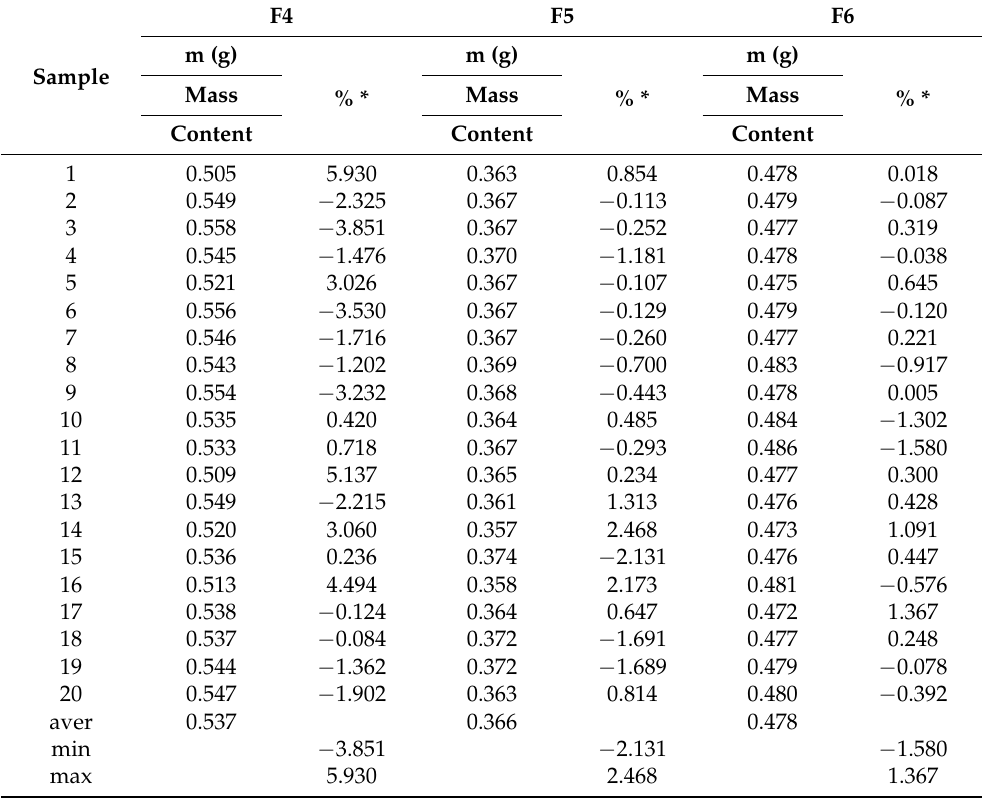
Table 4. Uniformity of mass test for three capsule